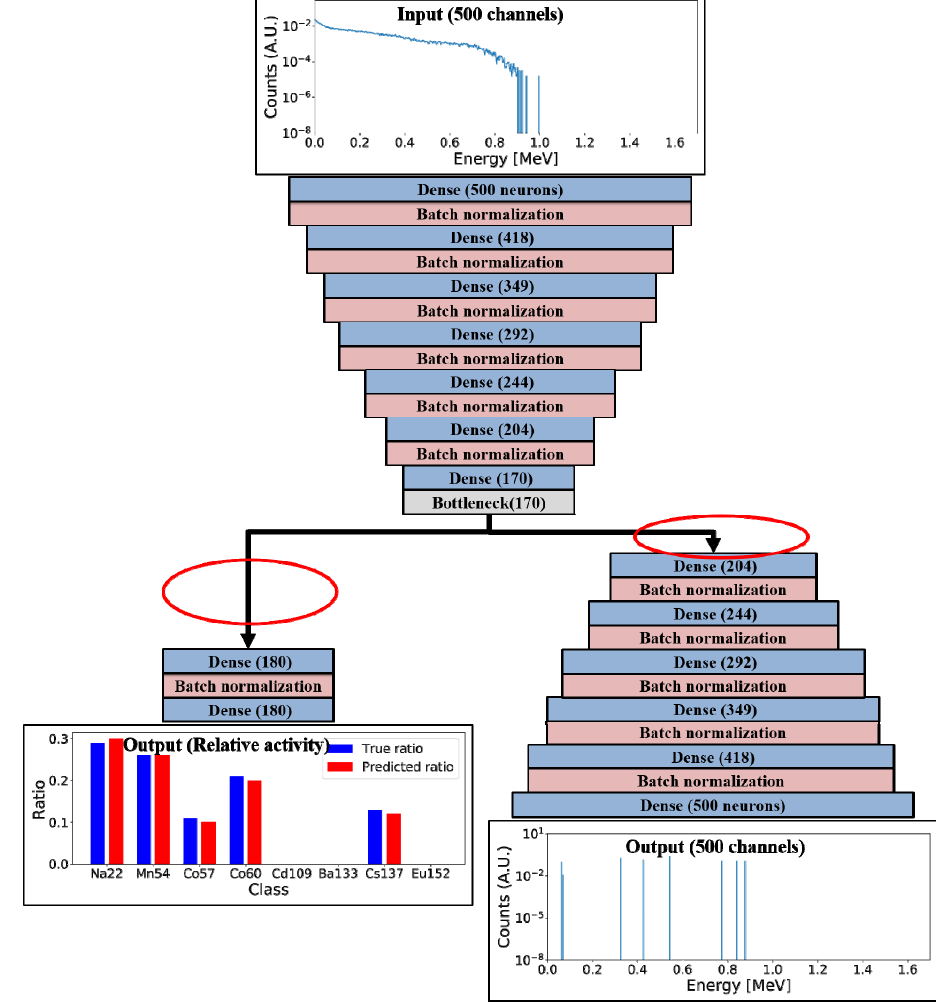
Figure 5. Structure of the baseline model for model enhancement (The red circles indicate the locations at which the deep learning modules are attached).